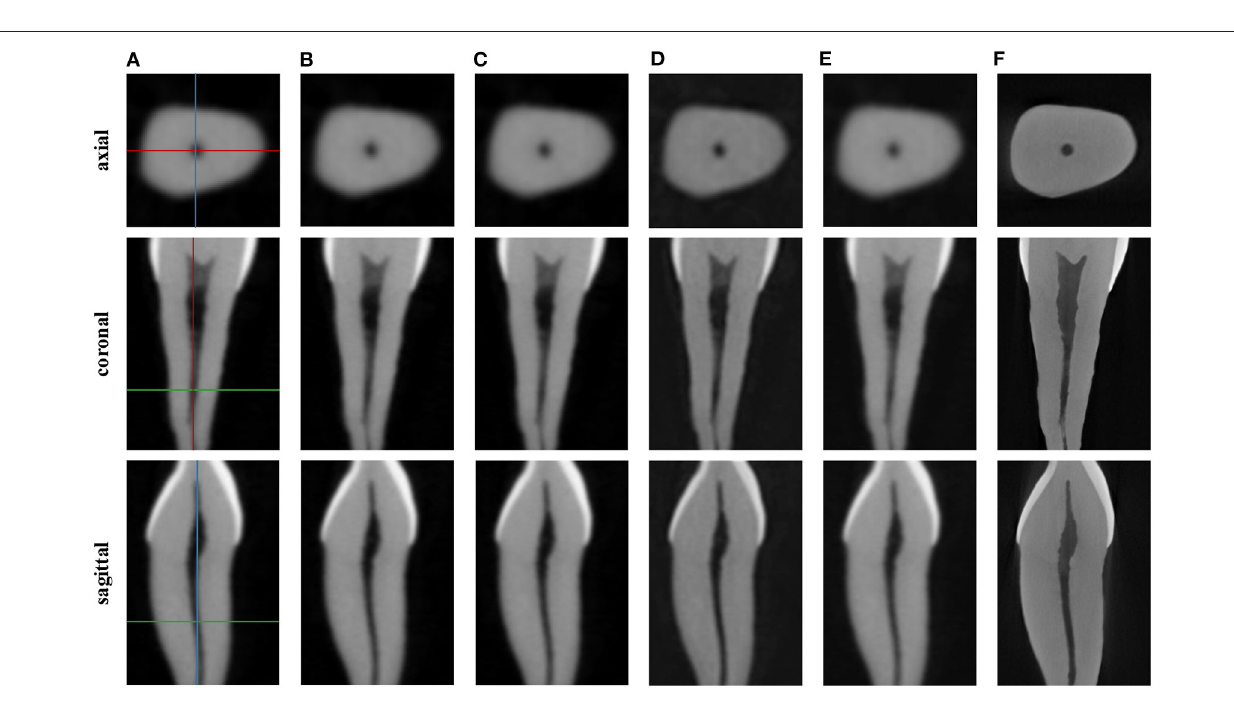
FIGURE 8 | Reconstruction results of dental image: (A) Cone beam computed tomography (CBCT), (B) NN, (C) LRTV, (D) TF-SISR, (E) NNTDTV, (F) micro-CT ( µ CT). Each column corresponds to an axial, a coronal, and a sagittal slice. The location of the slices in the volume is illustrated on the CBCT images in colored